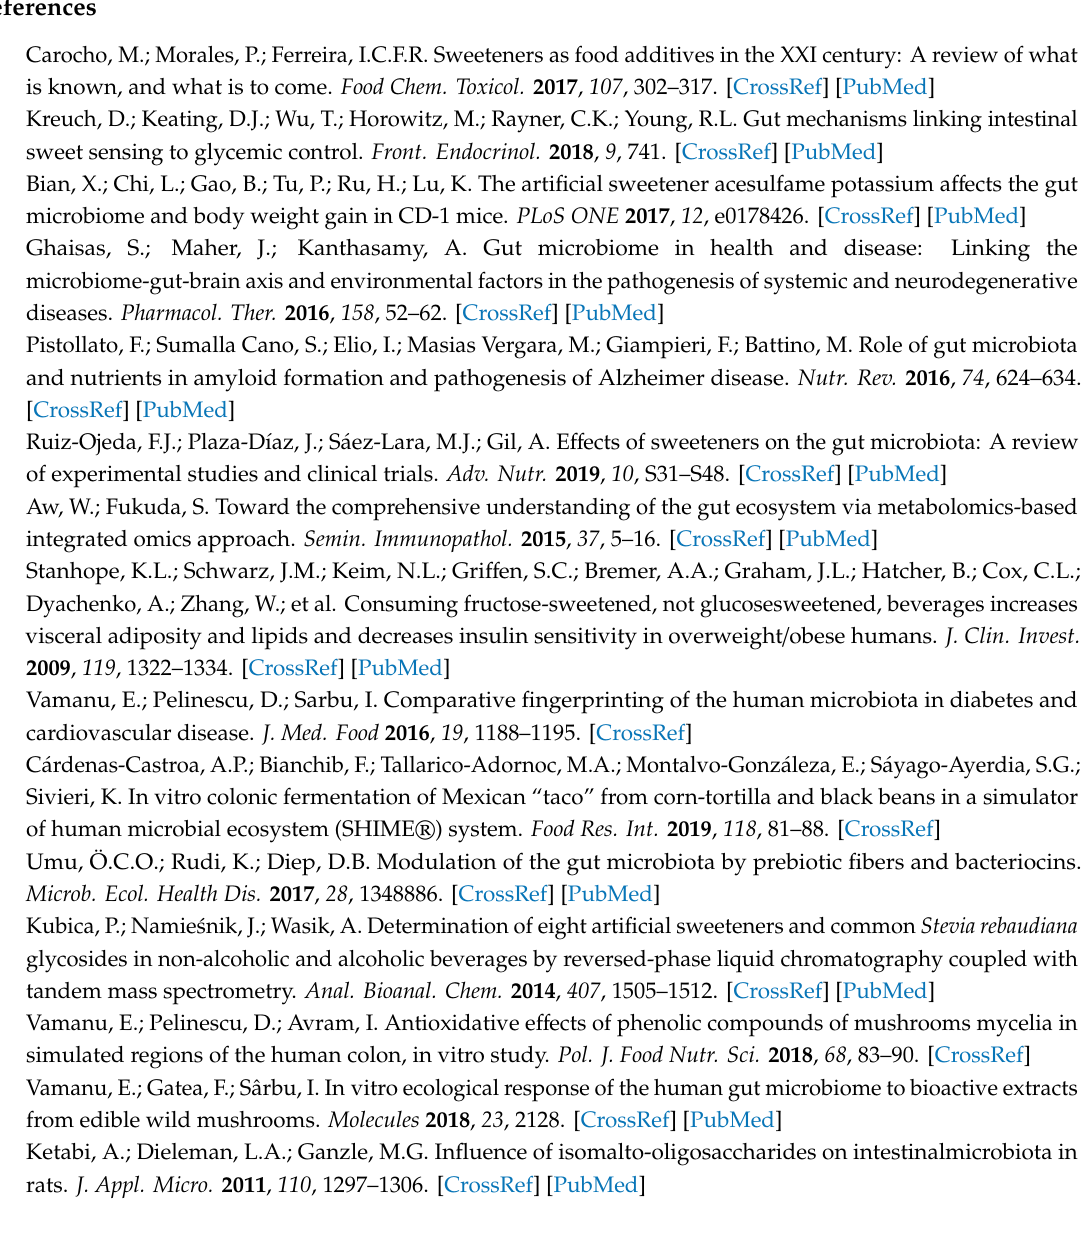
Figure S1: SCFAs levels ( µ g / mL) obtained after the in vitro tests through GIS1, Figure S2: pH values obtained during the in vitro tests (descending segment) through